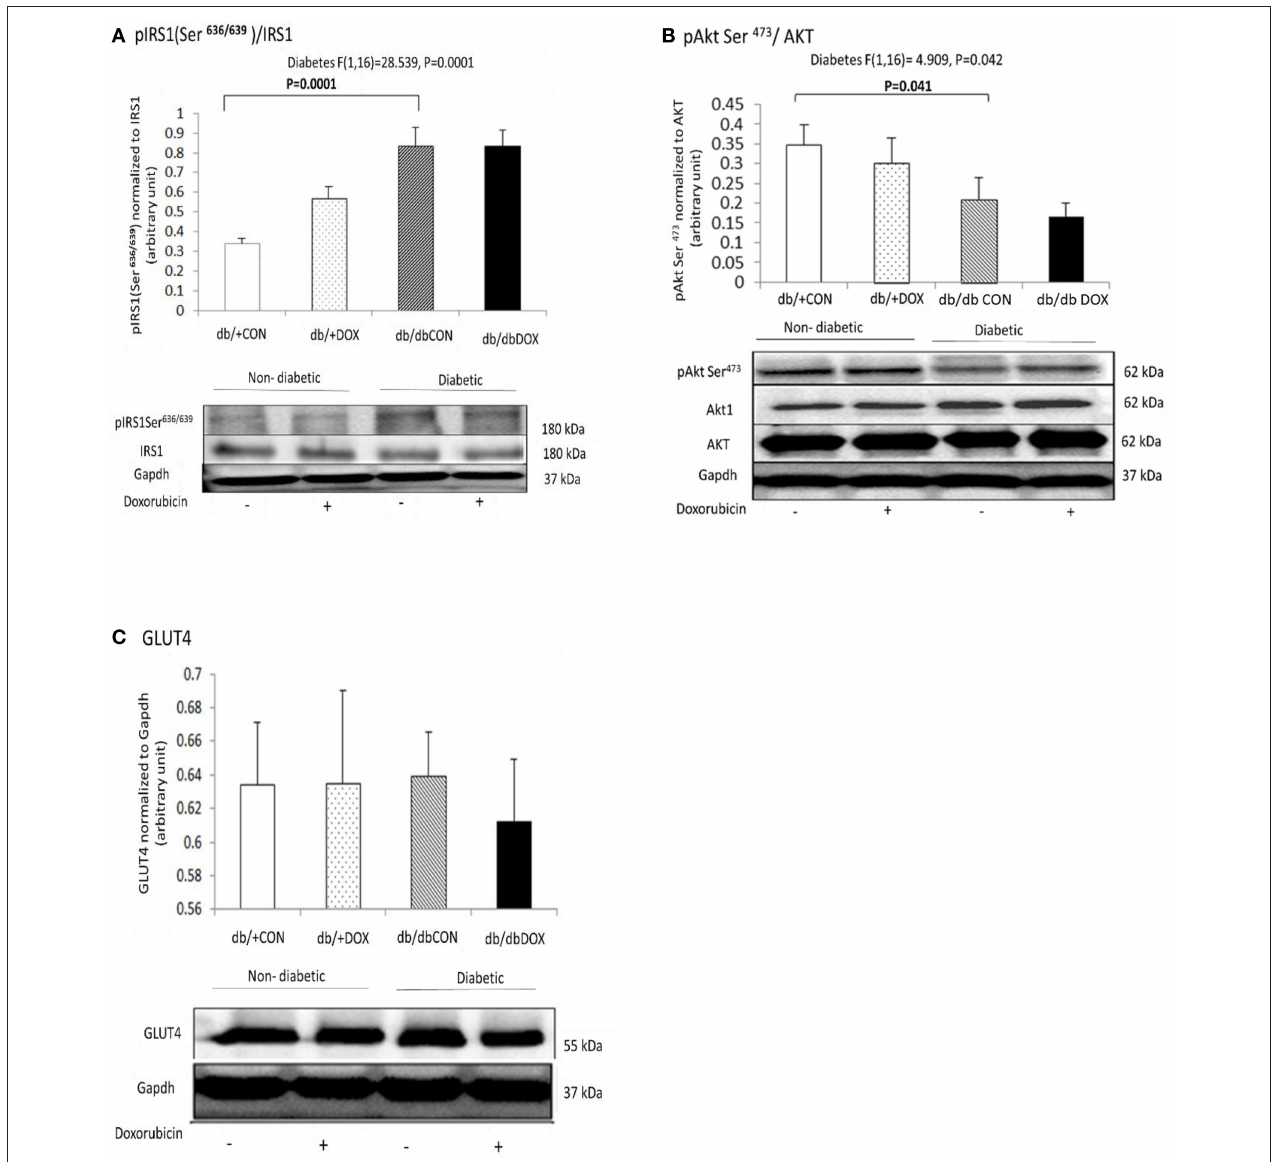
FIGURE 1 | Non-diabetic and diabetic skeletal muscle insulin signaling after DOX exposure examined by phosphorylation statuses of IRS1(Ser636/639) (A), Akt (Ser473) (B), and GLUT4 (C) are shown. Data are expressed as mean ± SEM.